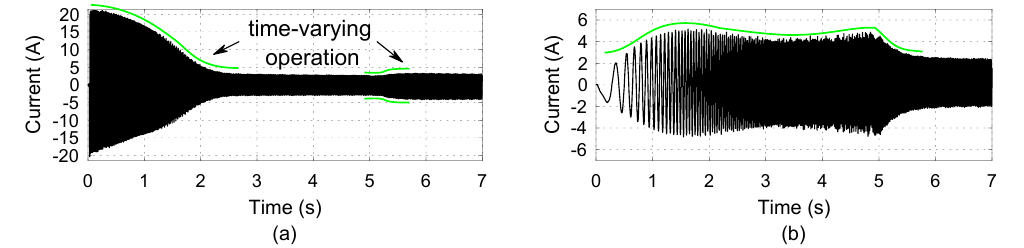
Figure 4. Stator current experimental waveform during startup transient of induction motor feds by: ( a ) Power grid. ( b ) Adjustable speed drive.